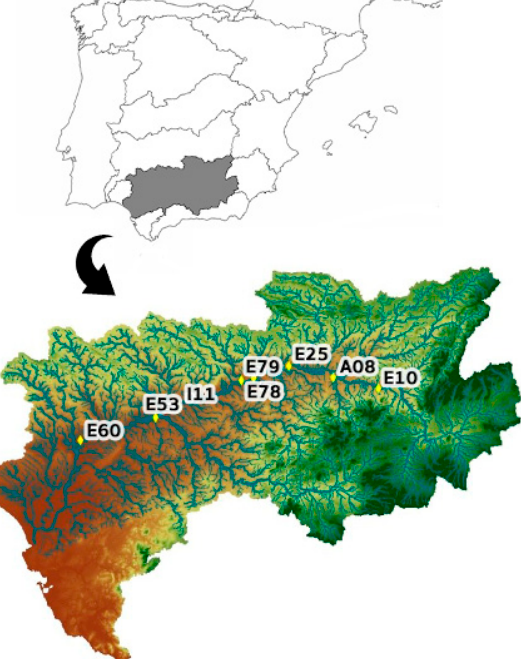
Figure 1. Control points on the main Guadalquivir’s river axis: E10 (Pedro Marín), A08_101 (Mengibar), E25 (Marmolejo), E78 (El Carpio), E79 (Villafranca), I11 (Fuente Palmera), E53 (Peñaflor), and E60 (Alcalá del Río).